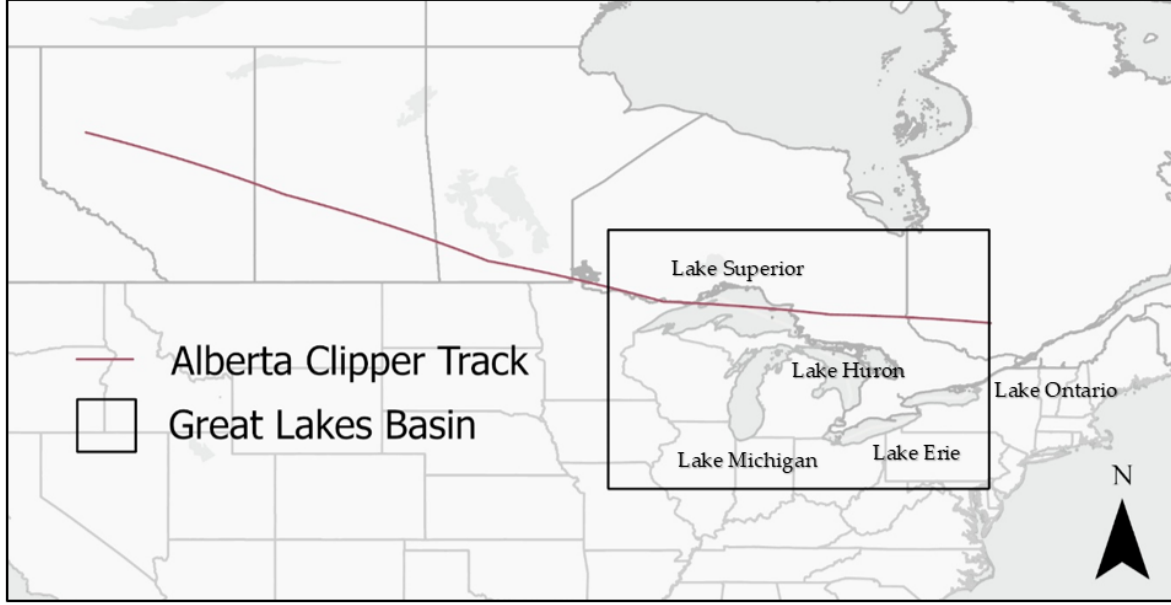
Figure 1. Climatological track of Alberta Clippers based on [2]. The red line denotes the track while the outlined rectangle encapsulates the Great Lakes Basin.